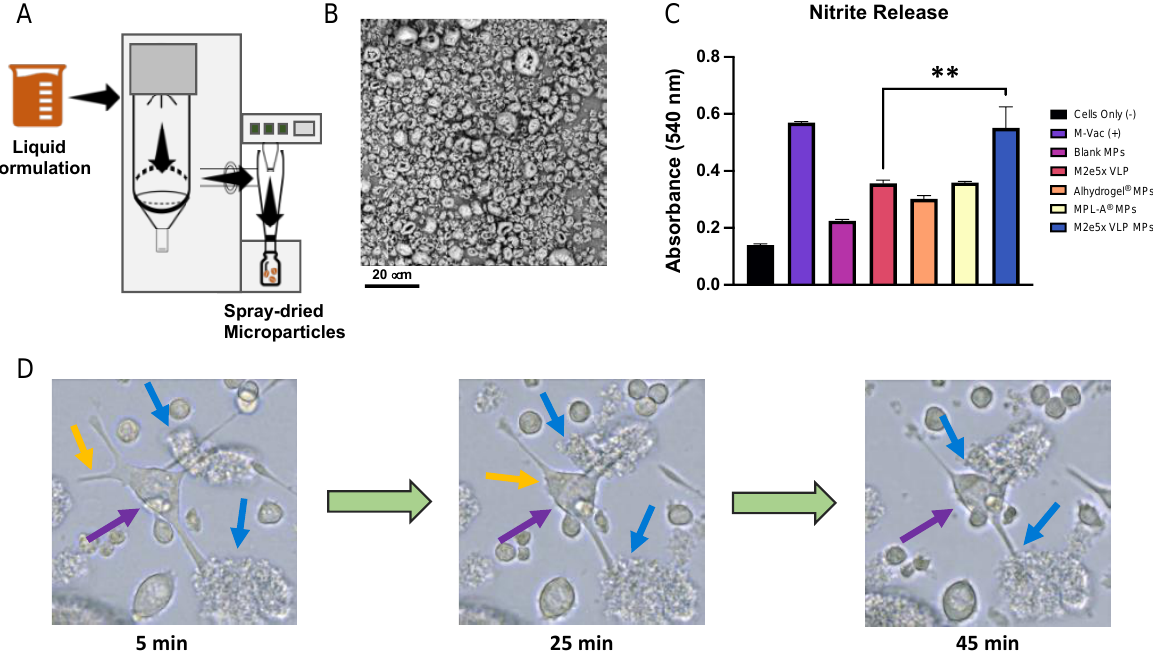
Figure 1. Formulation and in vitro immunogenicity of M2e5x VLP MPs. ( A ) Schematic of spray- drying process used to produce M2e5x VLP and adjuvant microparticles. ( B ) SEM image of M2e5x VLP MPs with scale bar of 20 µ m. ( C ) Nitrite release indicates that M2e5x VLP MPs produce significantly higher amounts of nitrite compared to M2e5x VLP alone (** p < 0.01). ( D ) Brightfield images (60 × magnification) to visualize antigen uptake in dendritic cells during live-cell imaging. At 5 min post treatment, cells are in contact with clusters of M2e5x VLP MPs. The purple arrow indicates the cell body of the dendritic cells, blue arrows indicate two M2e5x VLP MP clusters, and the yellow arrow indicates a highlighted dendrite. At 25 min, the highlighted dendrite at 5 min is internalized and the other dendrites begin to pull the MP clusters closer to the cell body. At 45 min, the cell body is in direct contact with an MP cluster to facilitate potential antigen uptake. A video time-lapse of this interaction is included in Supplementary Materials (Supplementary Video 1).